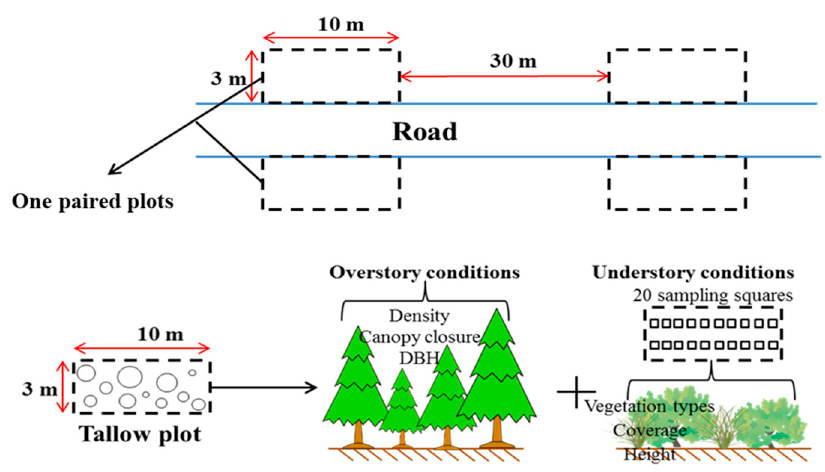
Figure 2. The design of rectangular plots and site/stand condition variables collected to study tallow colonization and spread along habitat edges (roadways and file lines).